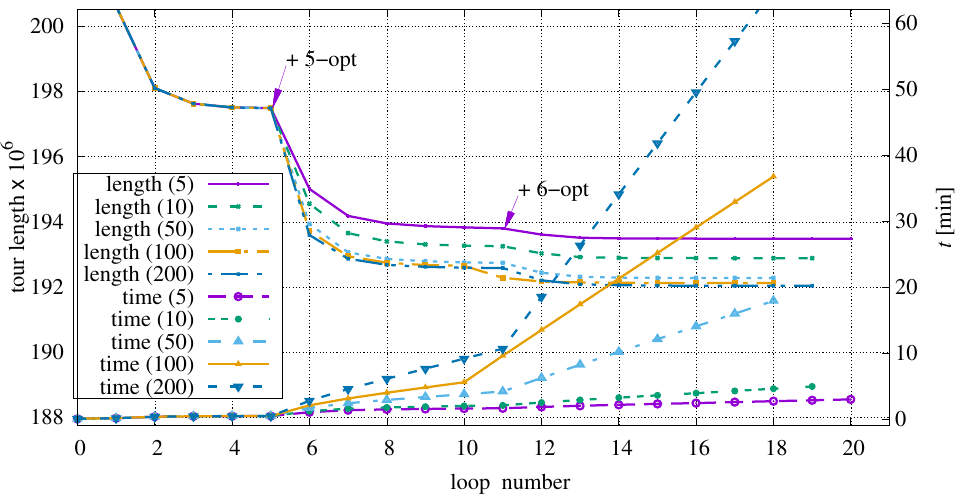
Figure 9. Influence of maxEdgeDist exemplified on instance C316k.0. For each parameter set, there are two curves depending on the loop number: one shows the current tour length and the other shows the elapsed time t . The magenta curve ( maxEdgeDist = 5) has two kinks at loop = 5 and loop = 10. At these locations, the next k -opt permutations are activated. At the same loop positions, the time curve also has kinks because enabling more complex permutations increases the time needed for one loop over all P positions. Once the majority of successful permutations is performed, the duration per loop remains nearly constant until the set of enabled permutations is further